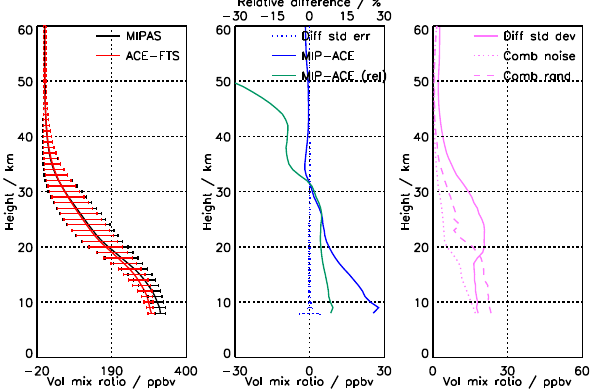
Figure 7. Comparison of N 2 O from Aura-MLS and MIPAS re- duced resolution (V5R_N2O_224 and V5R_N2O_225). Details as in Fig.